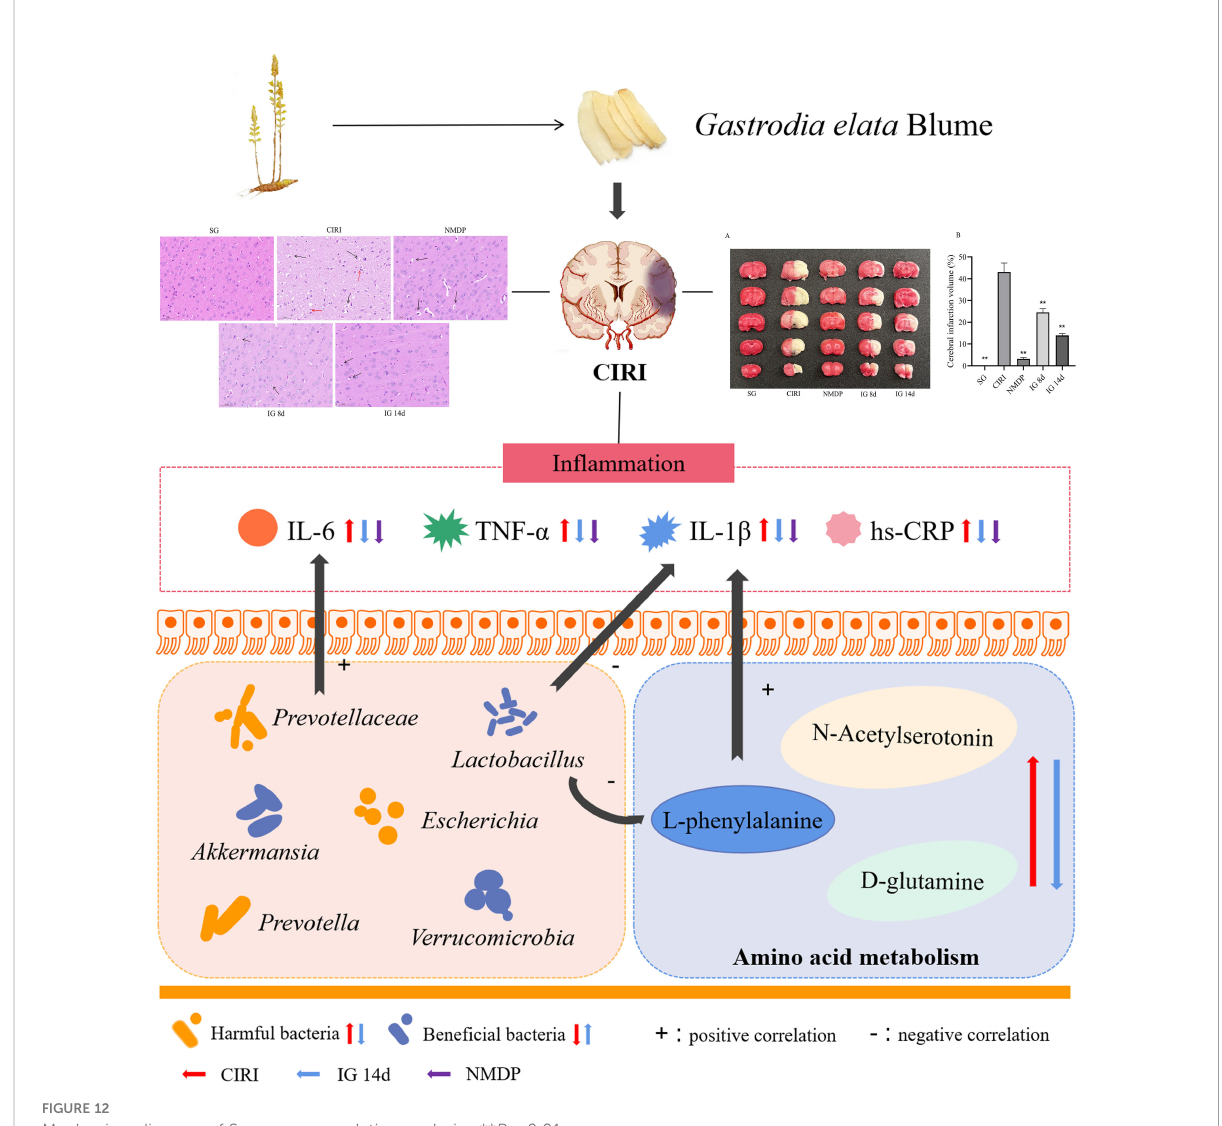
FIGURE 12 Mechanism diagram of Spearman correlation analysis. ** P <